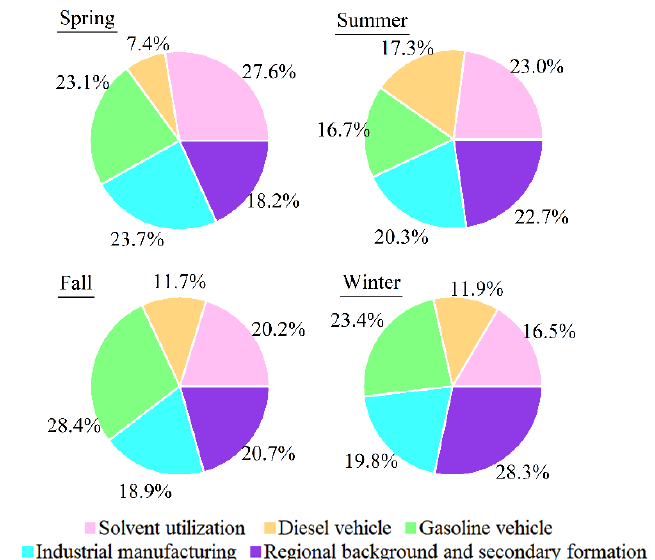
Figure 10. Source contributions of five factors analyzed by PMF in spring, summer, fall and winter.